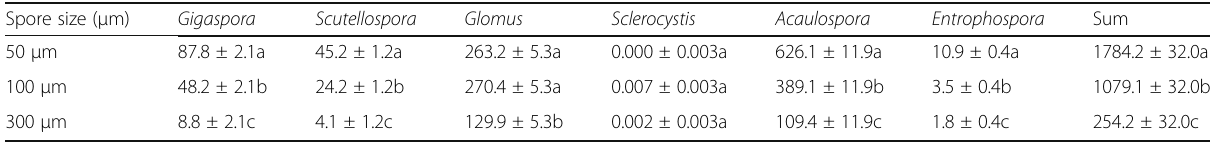
Table 8 Spore density (100 g − 1 of dry soil) and types of genera at different spore size ( μ m)